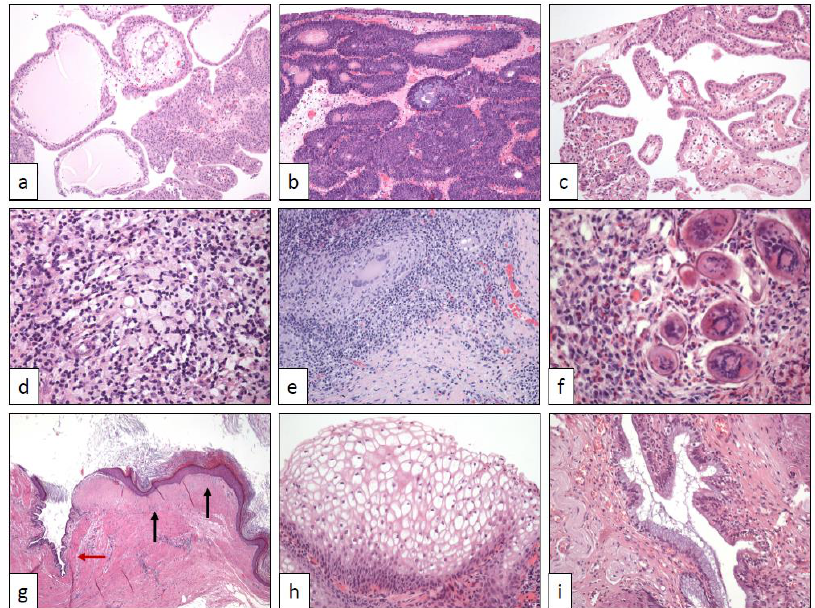
Figure 1. ( a ) Urothelial papilloma (40 × ), ( b ) inverted urothelial papilloma (100 × ), ( c ) nephrogenic adenoma (100 × ), ( d ) xanthogranulomatous inflammation (250 × ), ( e ) post-BCG inflammatory changes (100 × ), ( f ) schistosomiasis (400 × ), ( g ) keratinizing desquamative squamous metaplasia of the ureter (squamous metaplastic epithelium (black arrows) are mixed with normal urothelium (red arrow)) (20 × ), ( h ) vaginal-type squamous metaplasia (250 × ), ( i ) endocervicosis (250 × ).